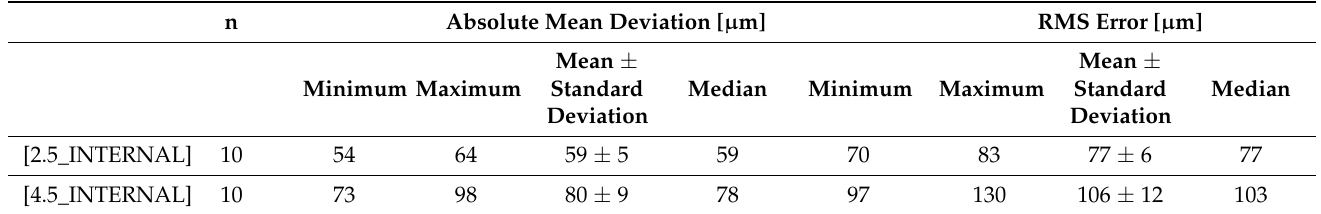
Table 2. Trueness [2.5_INTERNAL] and [4.5_INTERNAL].